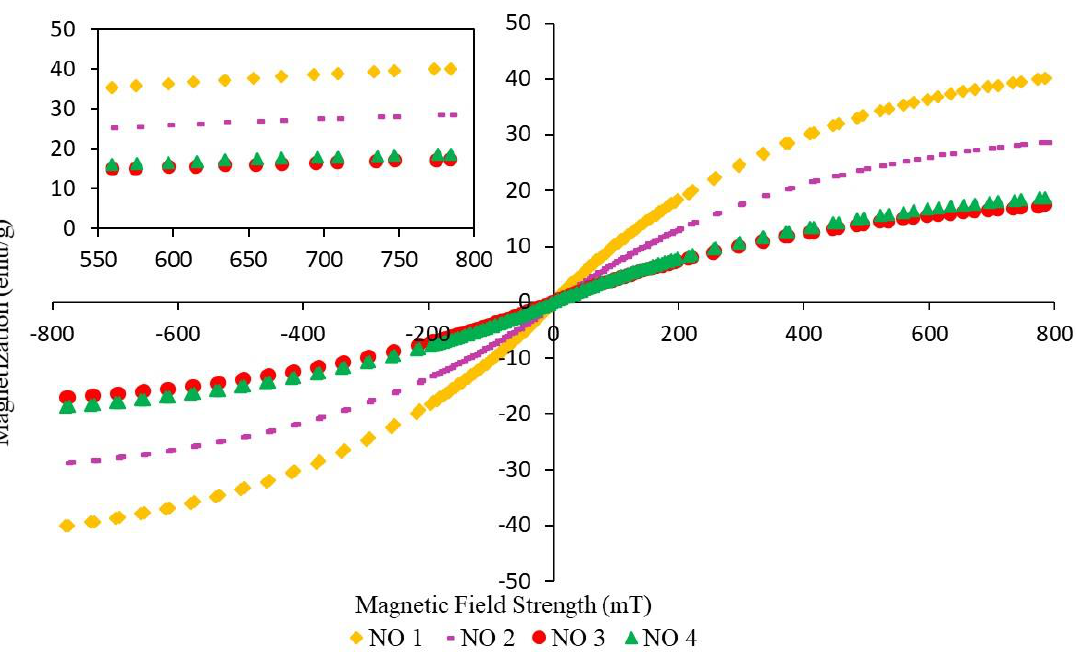
Figure 8. Magnetization curves of NR-based MREs for different ratios of LMO:AO.